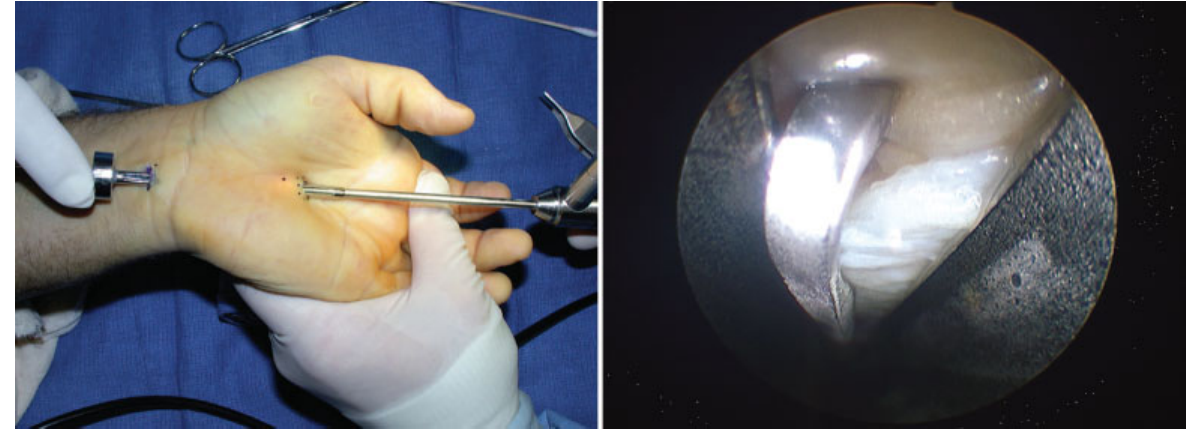
Fig. 4 Endoscopic carpal tunnel release — biportal technique. 21